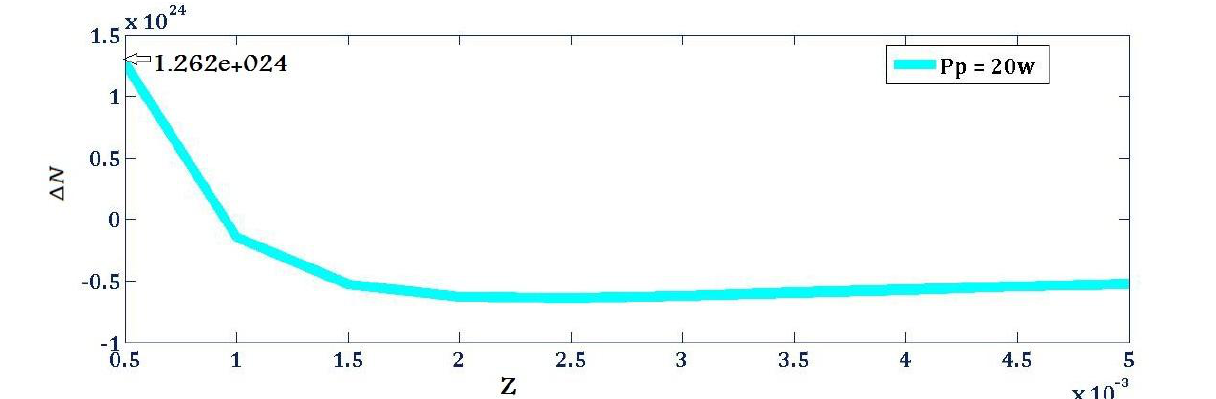
Figure 6. Population Difference along Z direction (path